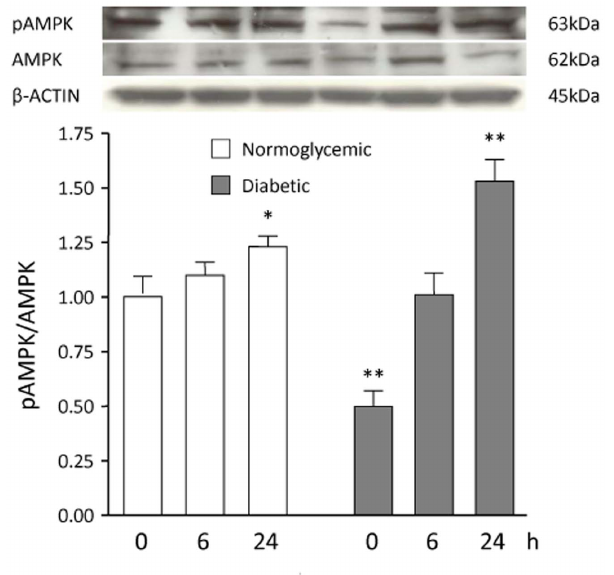
Figure 7. Effect of 17 b -estradiol on total and phosphorylated AMP-activated protein kinase (AMPK) abundance in VSMCs. VSMCs from normoglycemic and STZ-diabetic rats were incubated with 10 nM 17 b -estradiol for 0, 6 and 24 h in 2% FBS phenol-red free culture medium, to avoid any interference from the weak estrogenic agent phenol red. AMPK and pAMPK amounts in normoglycemic VSMCs at baseline were taken as 100%. A representative Western blot is shown. Values are mean 6 SEM (n=3). * p , 0.05 vs control.